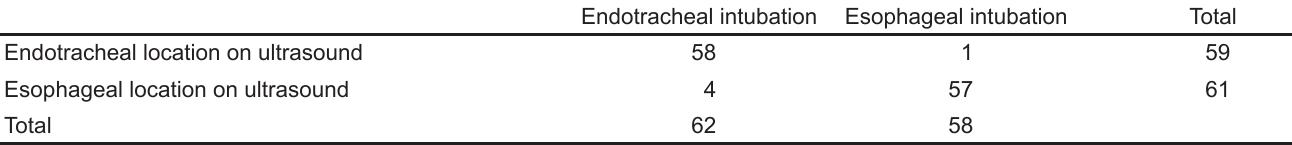
Table 1. Accuracy of the static technique for endotracheal intubation.